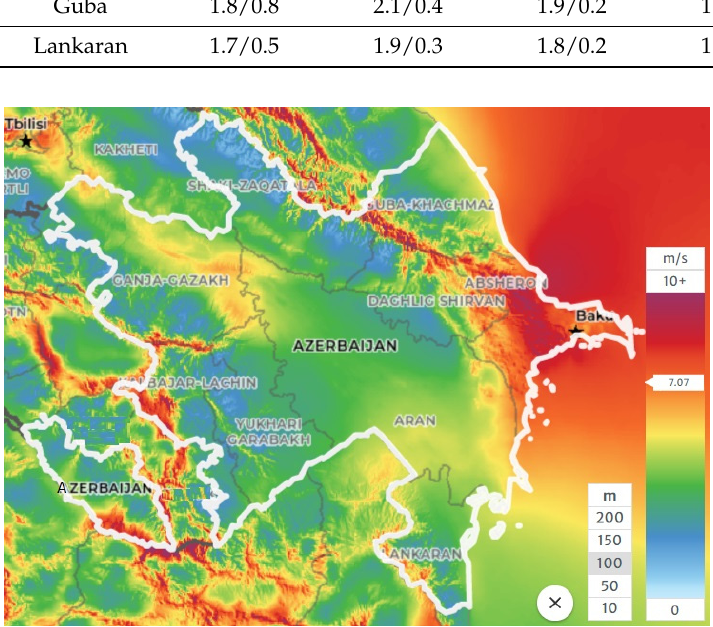
Figure 8. Mean wind speed at 100-m altitude [33].